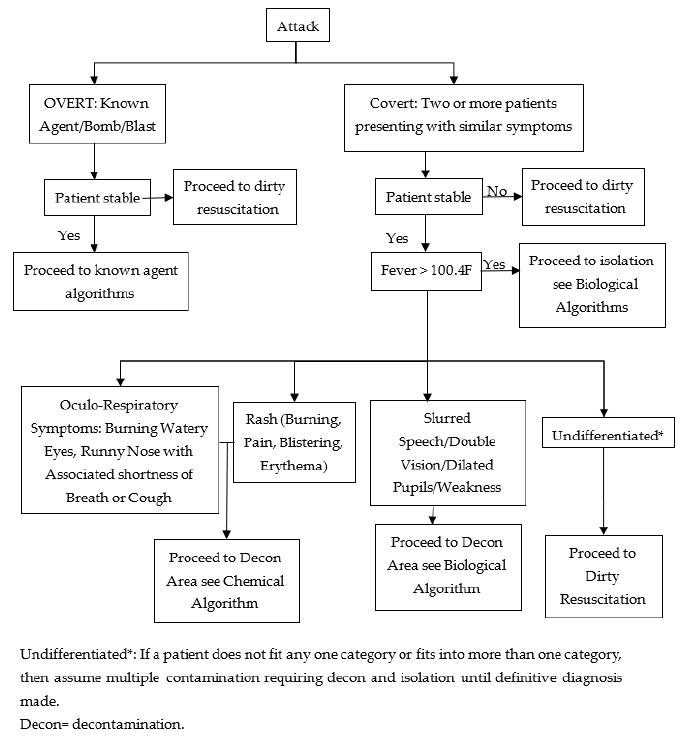
Figure 4. The attack algorithm. Int. J. Environ. Res. Public Health 2023 , 20 , x FOR PEER REVIEW